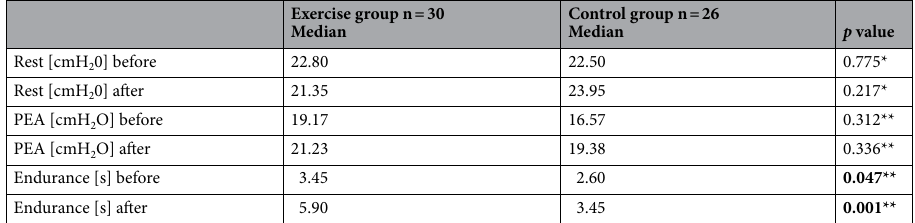
Table 4. Analysis of differences between groups in terms of the results of the resting pressure, peak pressure and endurance of the PFM using the perineometer. Values statistically significant are in bold. *Anova with repeated measures with Fisher post-hoc test. **Mann–Whitney